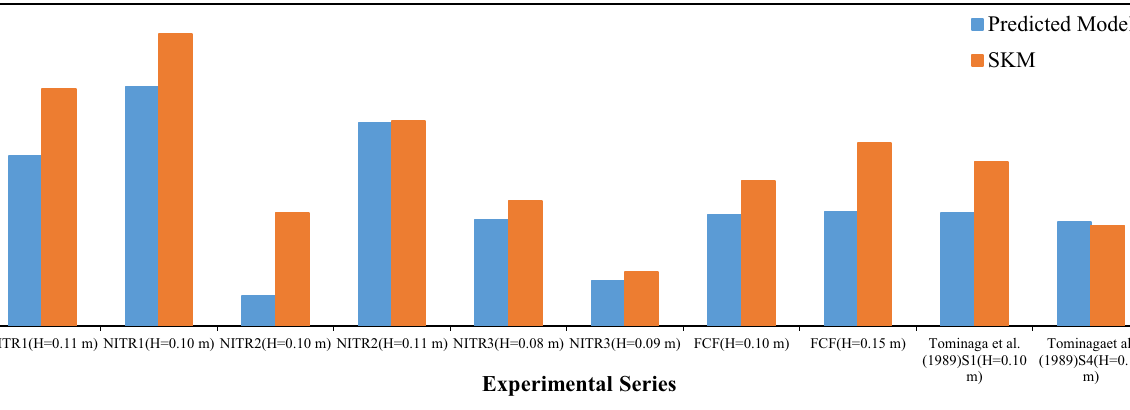
Fig. 15 MAPE results of depth-averaged velocity distribution by different models